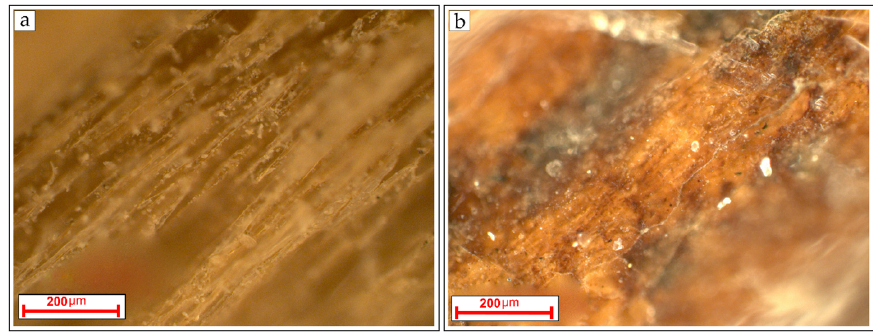
Figure 4. OM images of the analyzed sample: ( a )—wood and ( b